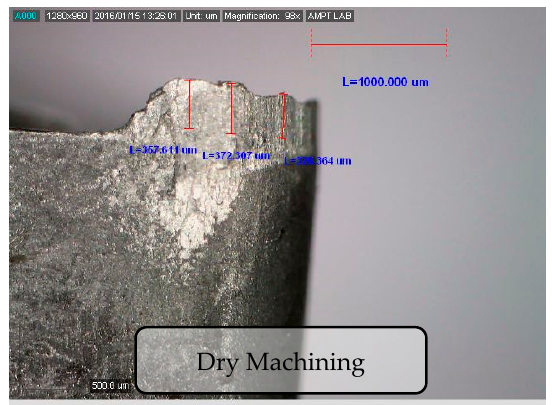
Figure 5. Built up edge (Experiment no-3).